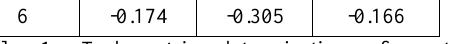
Table 1. Tachymetric determination of control point displacements